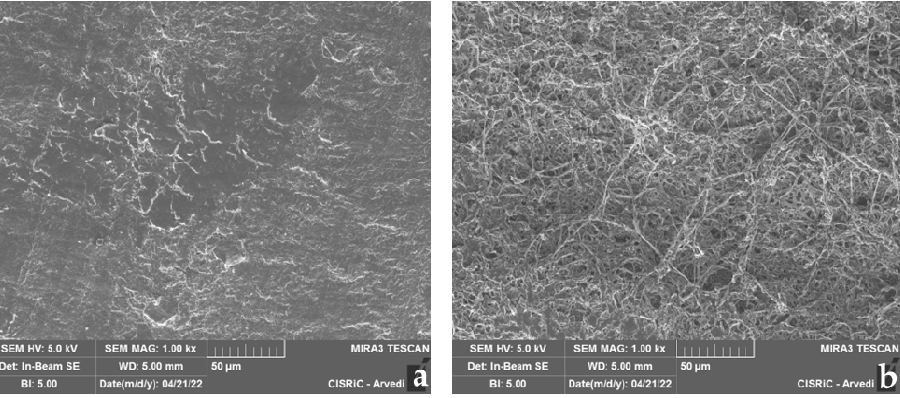
Figure 10. SEM image of control membrane without fungal growth ( a ); SEM image of T. mentagro- phytes 10326 mycelium on bovine membrane after 27 days ( b ).